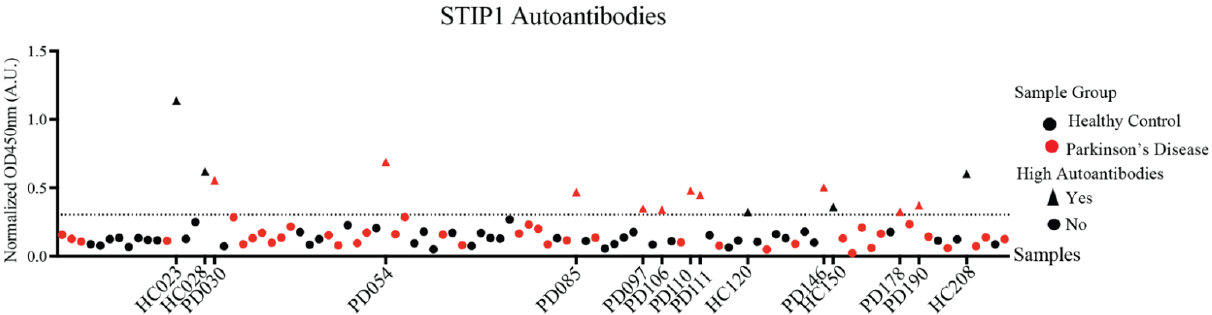
Figure 2. STIP1 autoantibody titres in the Parkinson’s disease patients and healthy controls. Plasma samples from the Parkinson’s disease (PD) patients and healthy controls (HC) ( n = 50 per group, 1:1000 dilution) were subjected to an STIP1 protein-based ELISA assay. Each data point represents the averaged normalised signal after the median centering of signals from various batches for each individual. Using the COPA outlier analysis, the dotted threshold line defines samples above the 75th percentile of the data plus the 1.5 interquartile range to have high autoantibodies. Samples with high autoantibodies are indicated as triangles while samples with low autoantibodies are represented by circles. Parkinson’s disease patient samples are represented in red while healthy controls are represented in black. Sample codes of Parkinson’s disease patients and healthy controls identified to have high STIP1 autoantibodies are listed on the x